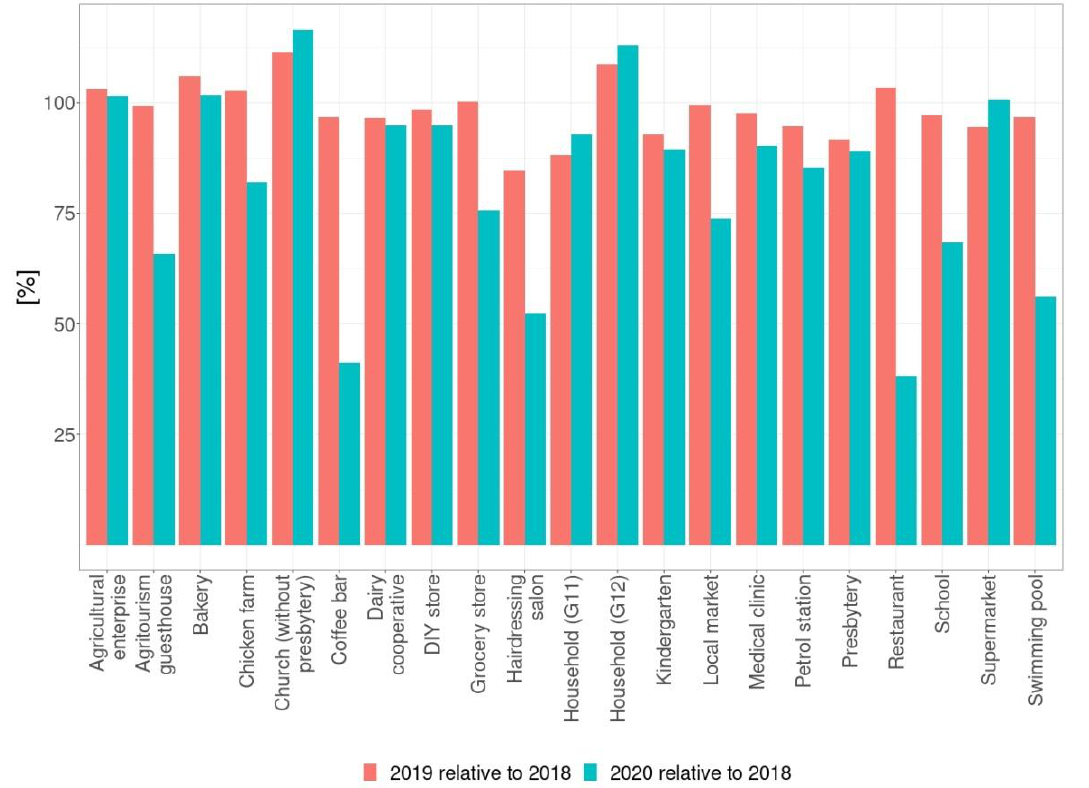
Figure 3. Relative demand for electricity broken down by types of activity.